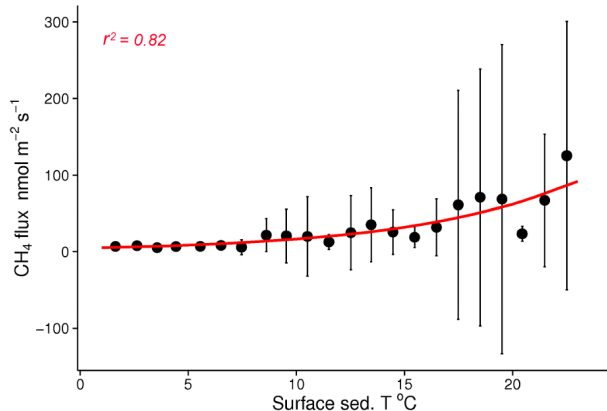
Figure 7. Relationship between lake CH 4 emissions and surface sediment temperature during summer, using all half-hourly CH 4 flux rates averaged by bins of 1 ◦ C across the three ice-free seasons. Error bars show the standard deviation of the CH 4 flux rates around the means within each averaging bin. The red line is a regression fit with r 2 = 0.82 ( p